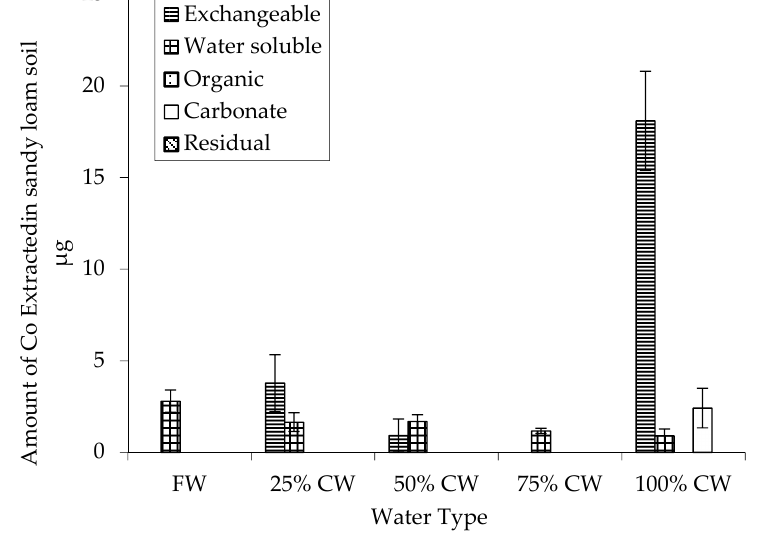
Figure 5. Mean recovered amounts of fractions of Co (in µ g) in sandy loam soil that had been irrigated with different concentrations of contaminated water.